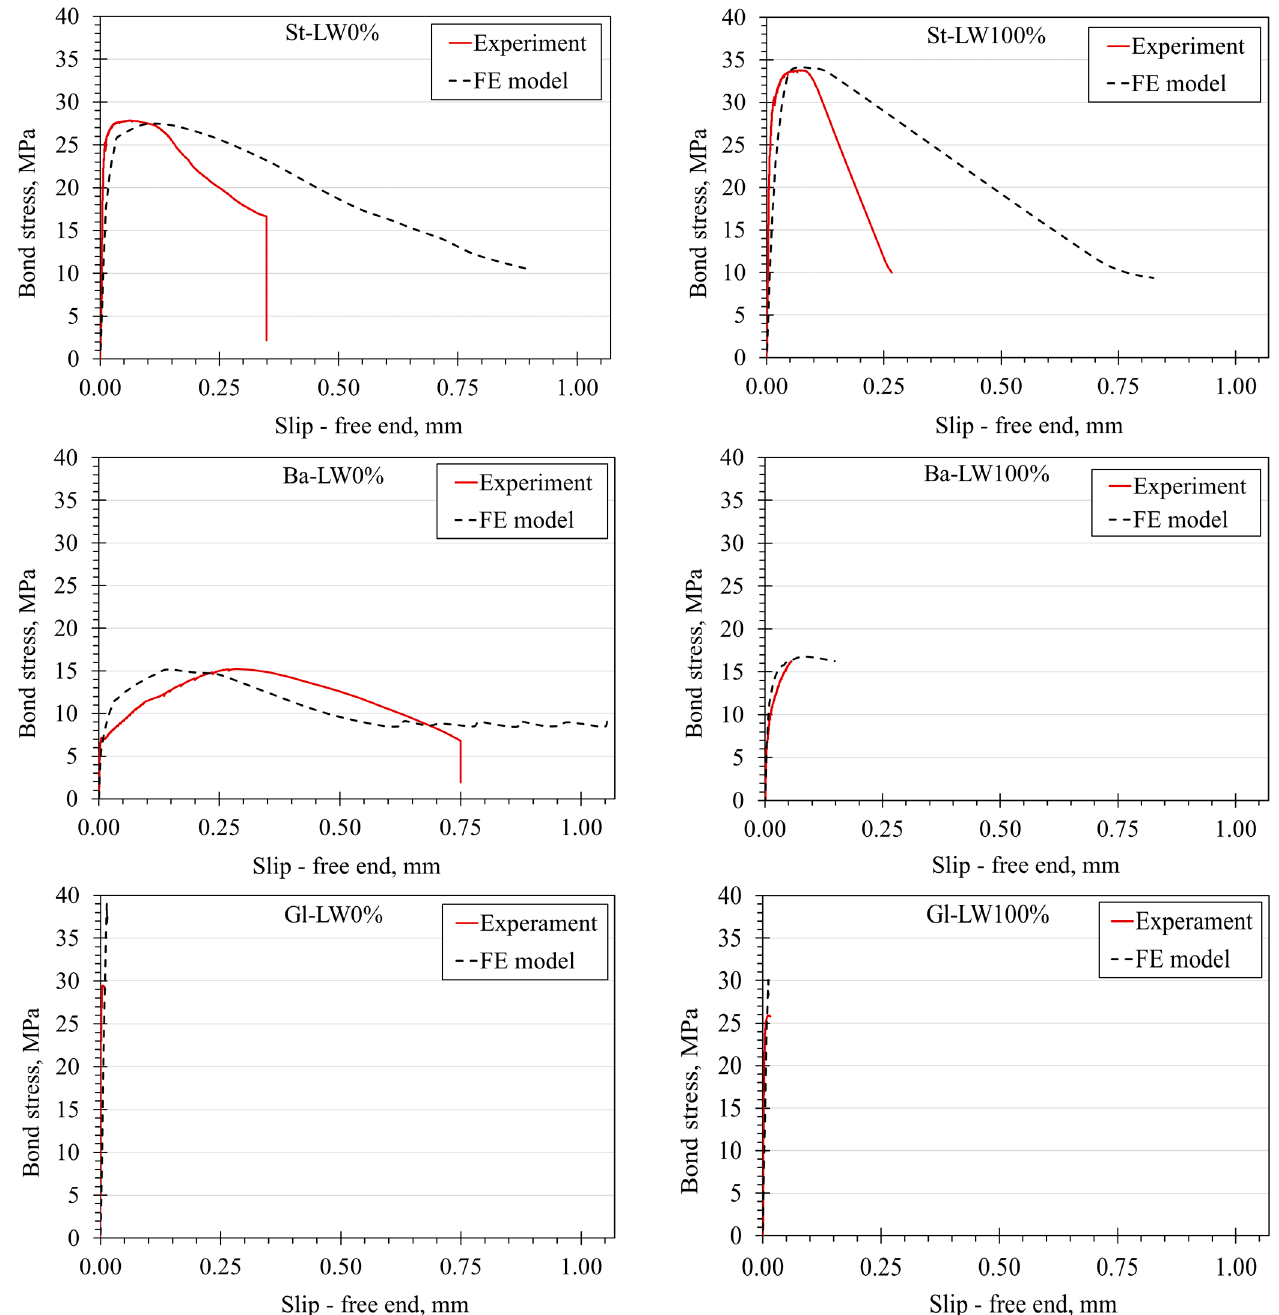
Figure 10. Comparison of the bond stress–relative slip curves between the experiment and numeri- cal modeling.